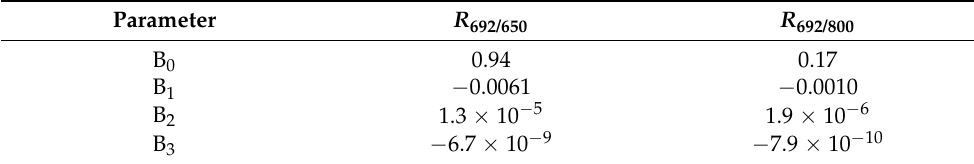
Table 1. The fitting parameters of R 692/650 and R 692/800 .